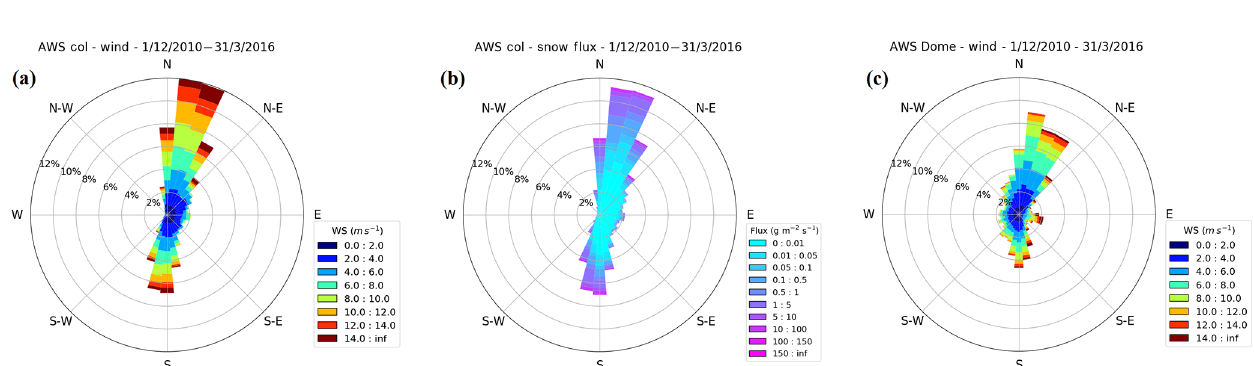
Figure 5. Overview of the period 2010–2016: (a) wind rose for the AWS Col, (b) rose of blowing snow fluxes at AWS Col with snow flux vertically integrated over 1m between 0.2 and 1.2m and (c) wind rose for the AWS Dome. Yearly wind roses and roses of blowing snow fluxes are provided as a